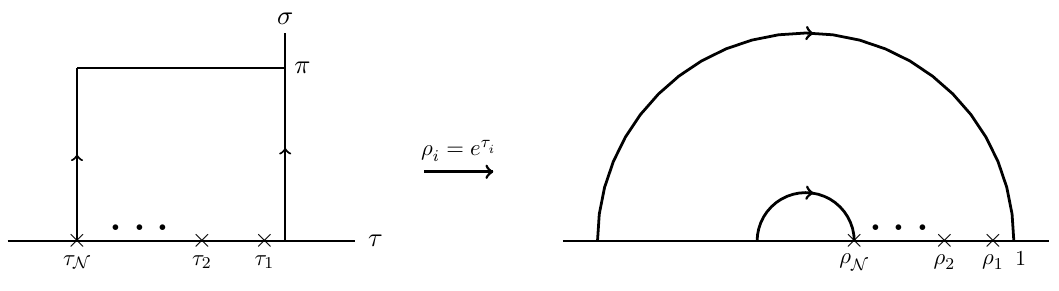
Figure 4 . The relation ρ = e τ i , i = 1 , · · · , N maps the strip it to the part of the annulus in the i upper half plane. The vertex operators lying on the strip at σ = 0 are mapped to the right side of the annulus. Here, τ N = − 2 π t and ρ = e − 2 πt are fixed. See [49]. N with τ the Euclidean time. The cylinder is formed by identifying the ends at σ = 0 , π